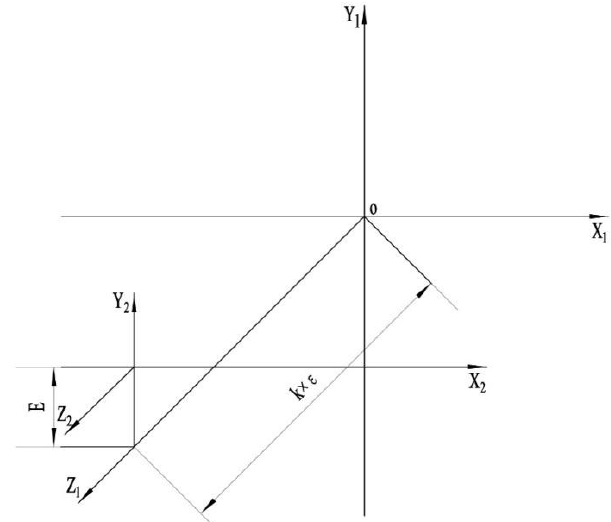
Figure 4. The coordinate conversion between S 1 and S 2 and S n and S 1 .